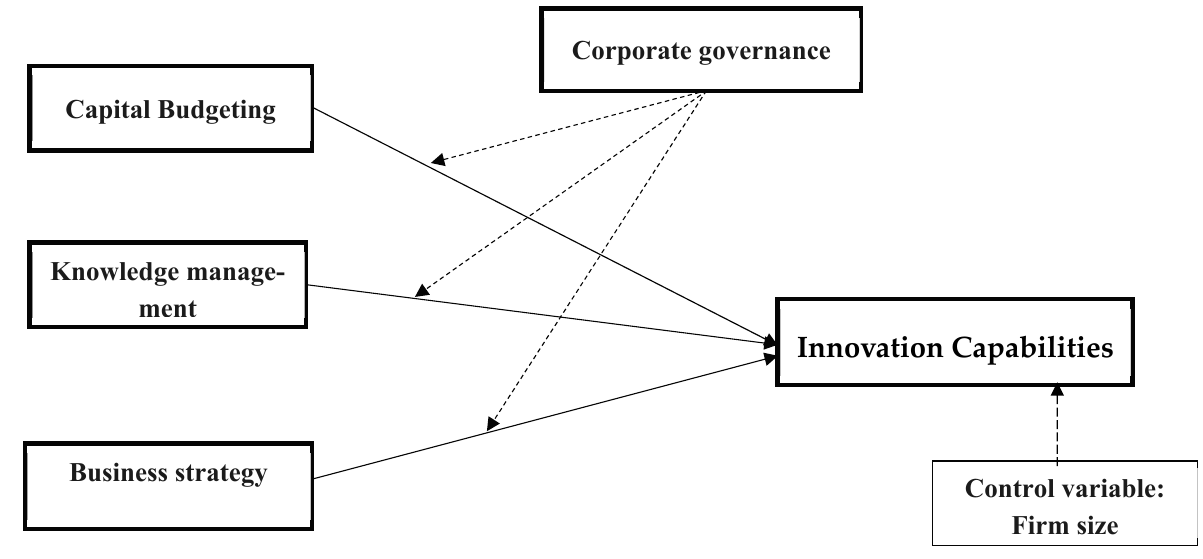
Figure 1. The proposed framework.